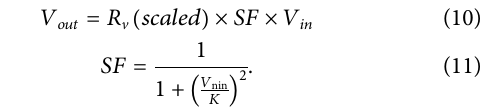
Frontiers in Earth Science |